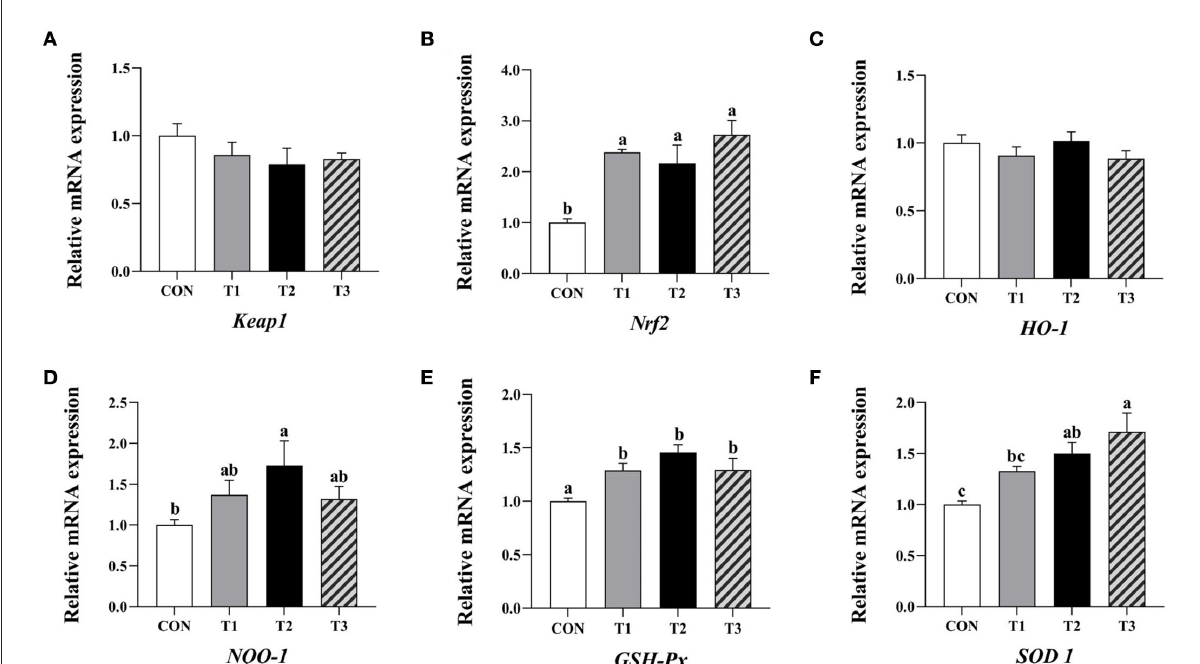
FIGURE3 Effect of quercetagetin on expression level of antioxidant related genes in liver of broilers. Values are means ± standard deviation ( n = 10). Above the bar no letter or the same letter mean no significant ( P > 0.05), while with different letter mean significant difference ( P < 0.05). Kelch-like ECH-associated protein 1 (Keap1) (A) , Nuclear factor E2 related factor 2 (Nrf2) (B) , Heme oxygenase-1 (HO-1) (C) , NAD(P)H: quinone oxidoreductase 1 (NQO-1) (D) , Glutathione peroxidase (GSH-Px) (E) , Superoxide dismutase 1 (SOD1) (F)